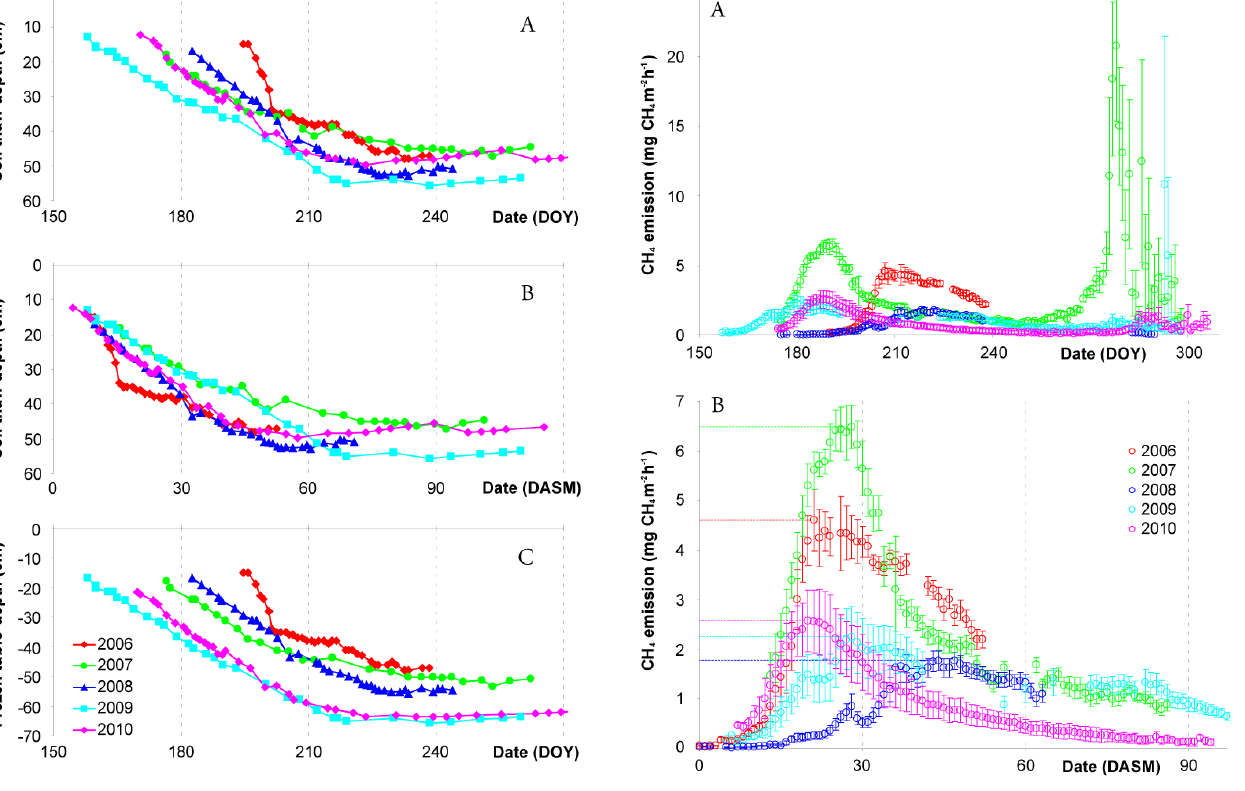
Fig. 4. CH 4 emission dynamics. A all measured fluxes, normalized to day of year (DOY); B growing season fluxes, normalized to day after snow melt (DASM). Each circle states the average between daily averaged hourly measurements of 6 or less individual cham- bers; error bars state the standard error between daily average values of individual